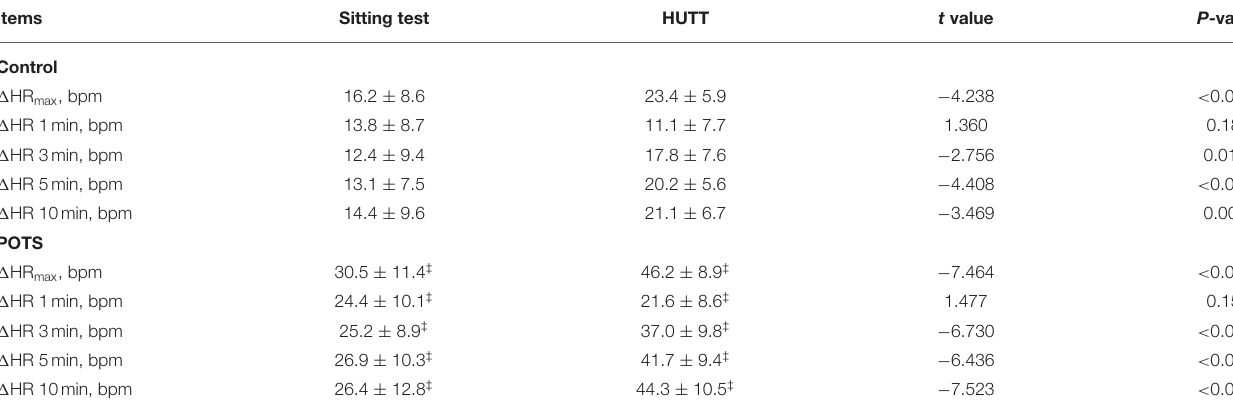
TABLE 2 | HR responses during the sitting test and the head-up tilt test (HUTT) at different time intervals ( x ± S ). Items Sitting test